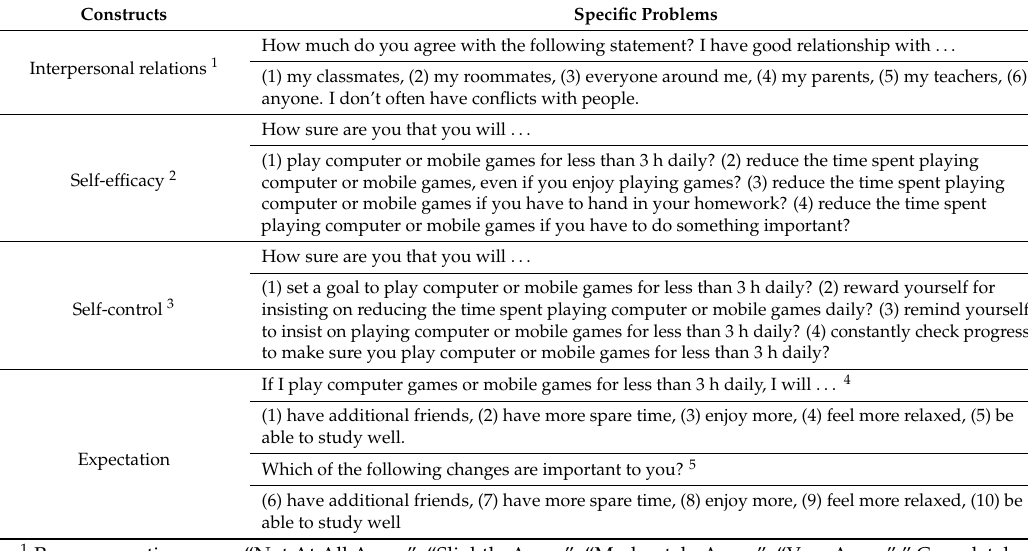
Table 1. Specific problems in interpersonal relationships and social cognitive theory